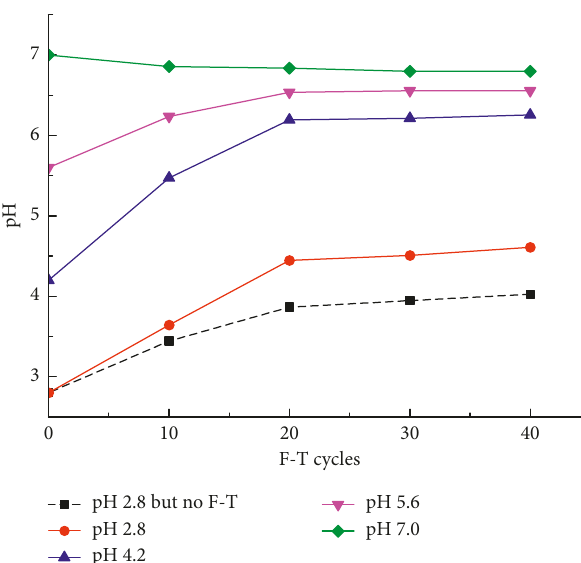
Figure 7: pH change of solutions immersed with sandstone after different F-T